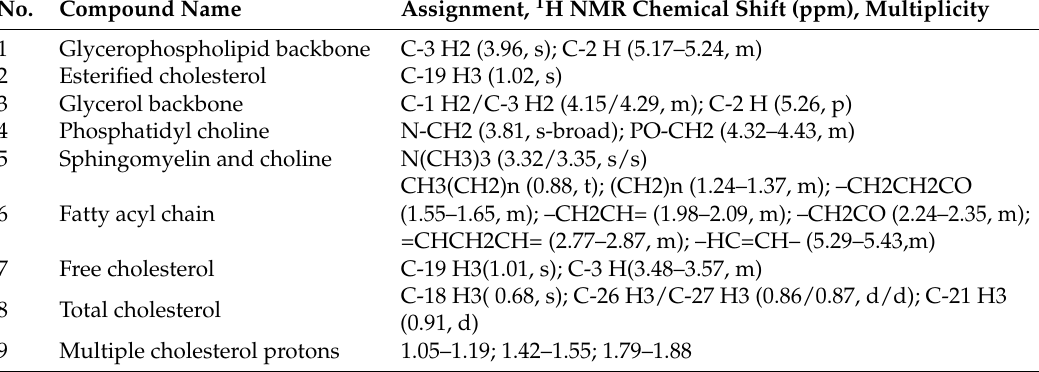
Table 2. Compounds identified in the non-polar extract of avian liver tissue from NMR data: peak numbers (as shown in Figure 2) and assigned chemical shifts